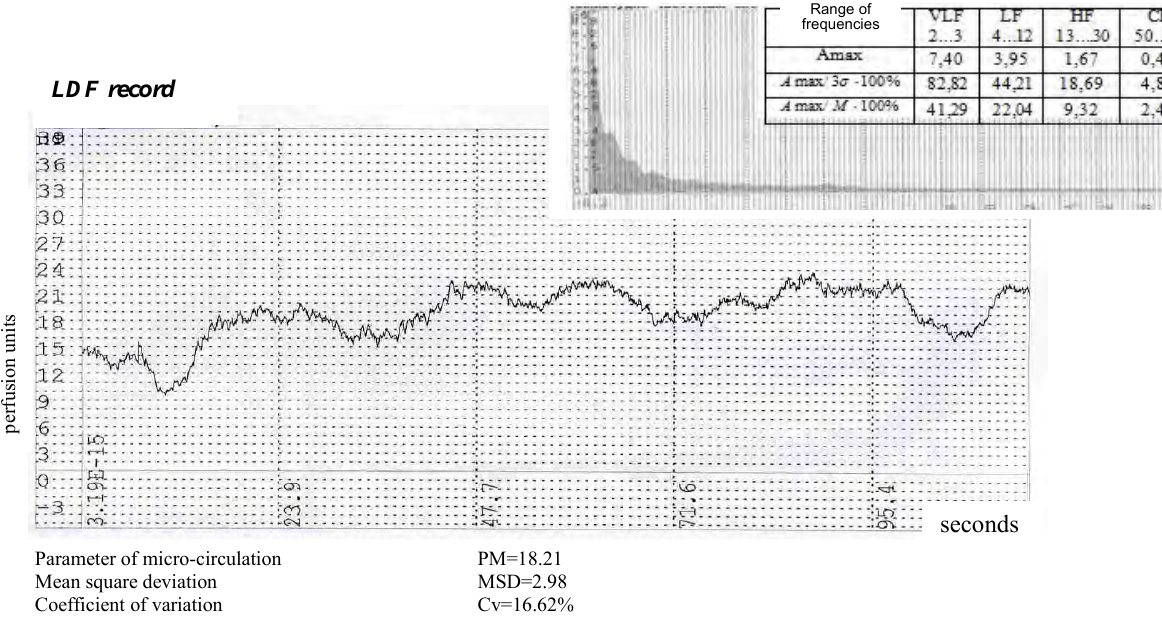
Fig.1. Daily monitoring of LDF record of 17 years old girl with standard type of micro-circulation at 8 a.m.